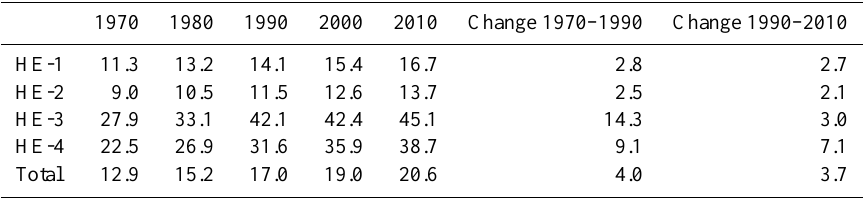
Table A17. Share of land equipped for irrigation in total cultivated land (percent).